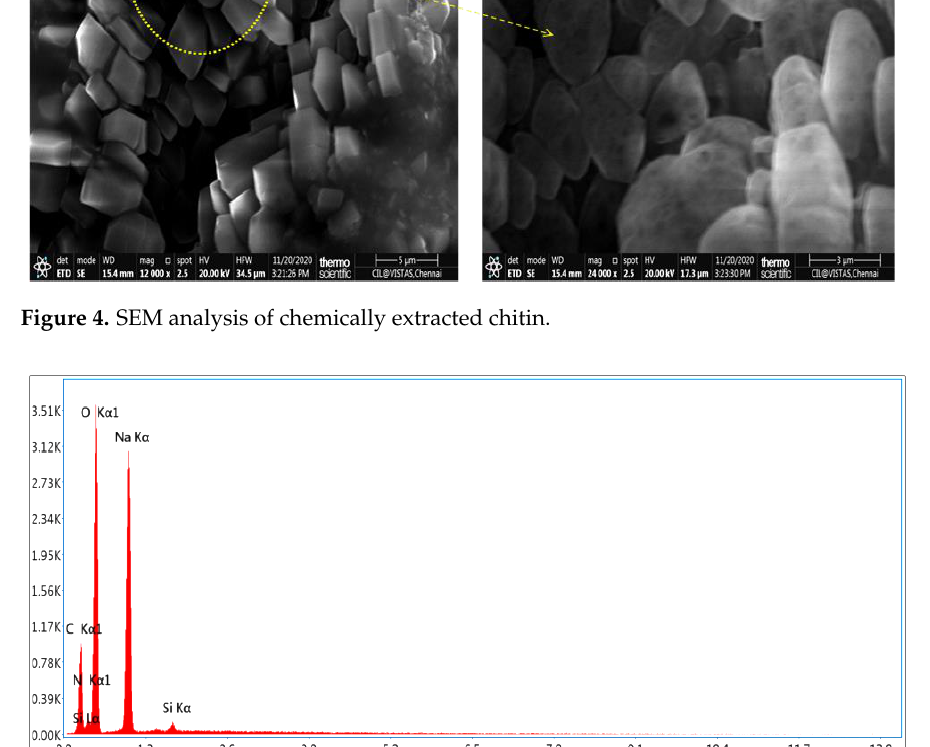
Figure 4. SEM analysis of chemically extracted chitin. Table 1. Energy-dispersive X-ray spectroscopy of chitin.